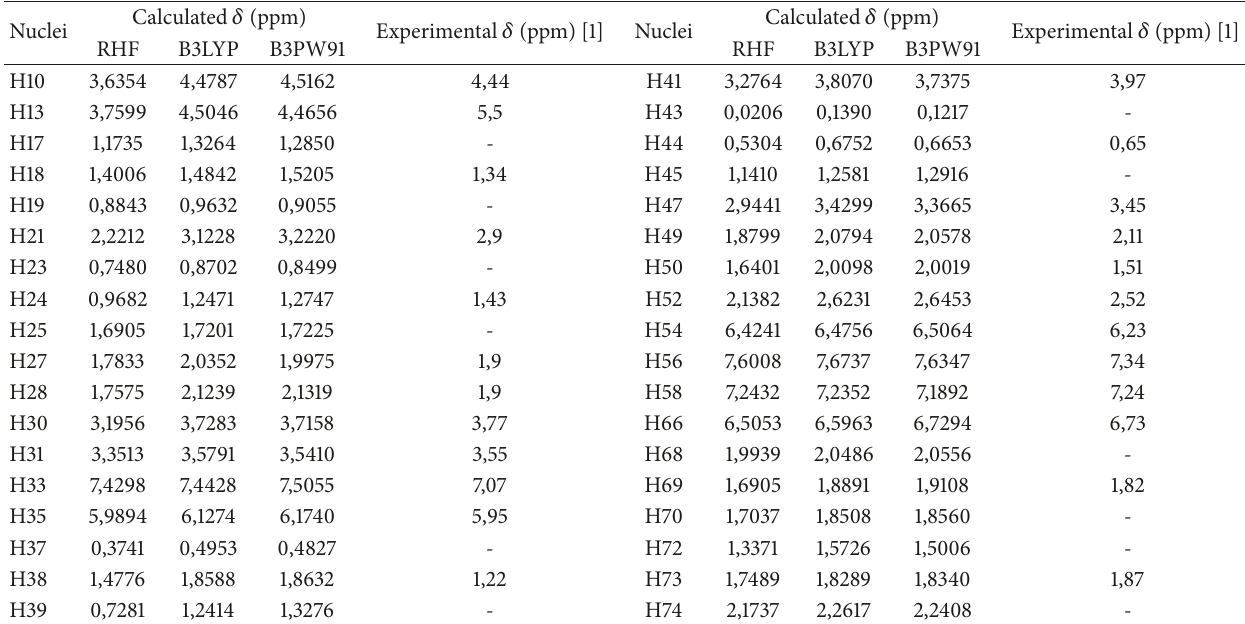
Table 7: Experimental and calculated 1 H NMR chemical shifts 𝛿 (ppm) of Rubescin E at the RHF, B3LYP, and B3PW91 levels in chloroform solution using the 6-311++G(d,p) basis